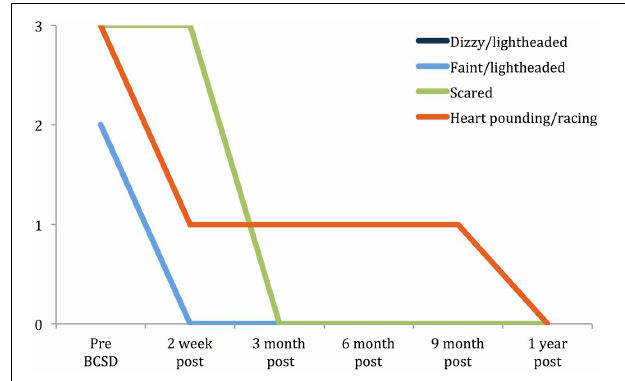
FIGURE 3 | Time Course of greatest reductions in Beck anxiety symptoms following BCSD in Case 1. Palpitations and dizziness were the largest reductions reported after BCSD. The largest magnitude reduction overall was feeling scared, which had fully decreased by 3 months, after the patient had begun Cognitive Behavioral Therapy. Scale: 0 = “Not at all.” 1 = “Mildly, but it didn’t bother me that much.” 2 = “Moderately—it wasn’t pleasant at times.” 3 = “Severely—it bothered me a lot.” Note: ratings for dizzy/lightheaded and faint/lightheaded were identical and overlapping.